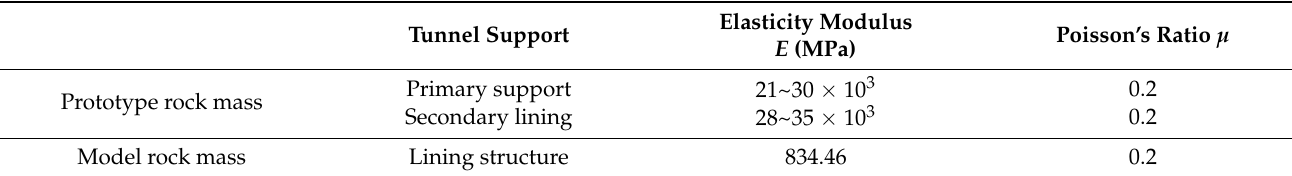
Table 2. Physical and mechanical parameters of rock mass.